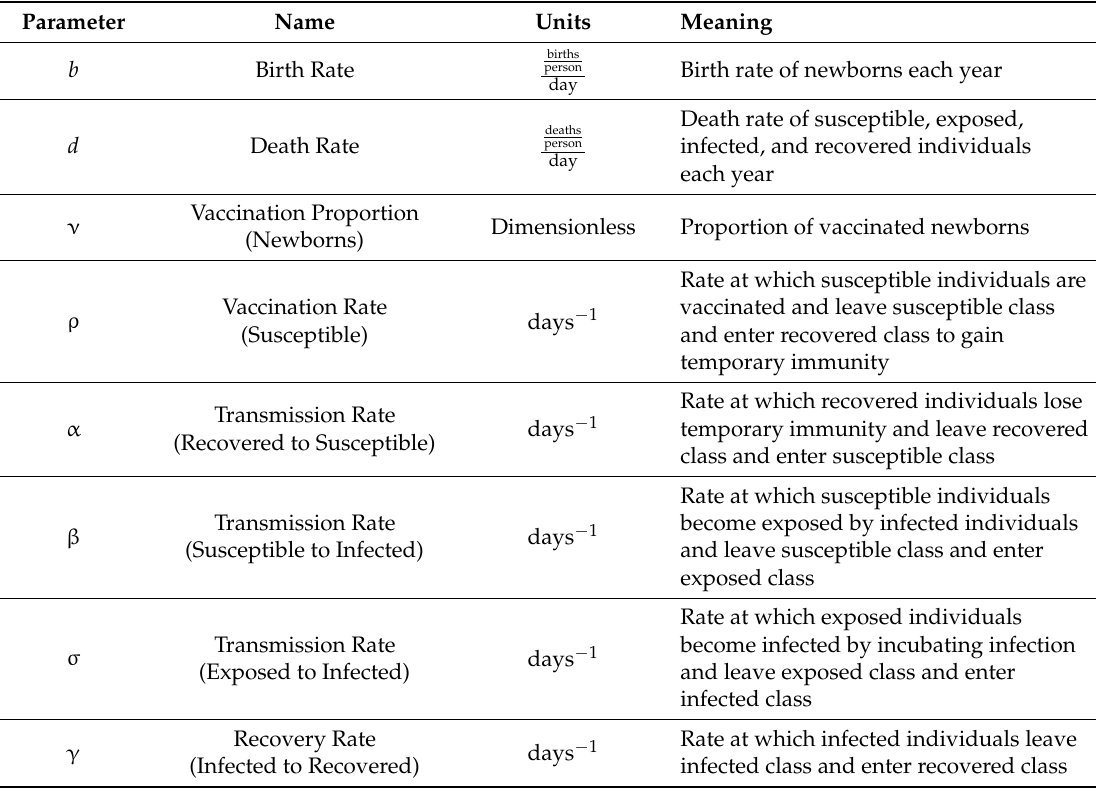
Table 2. Description of Model